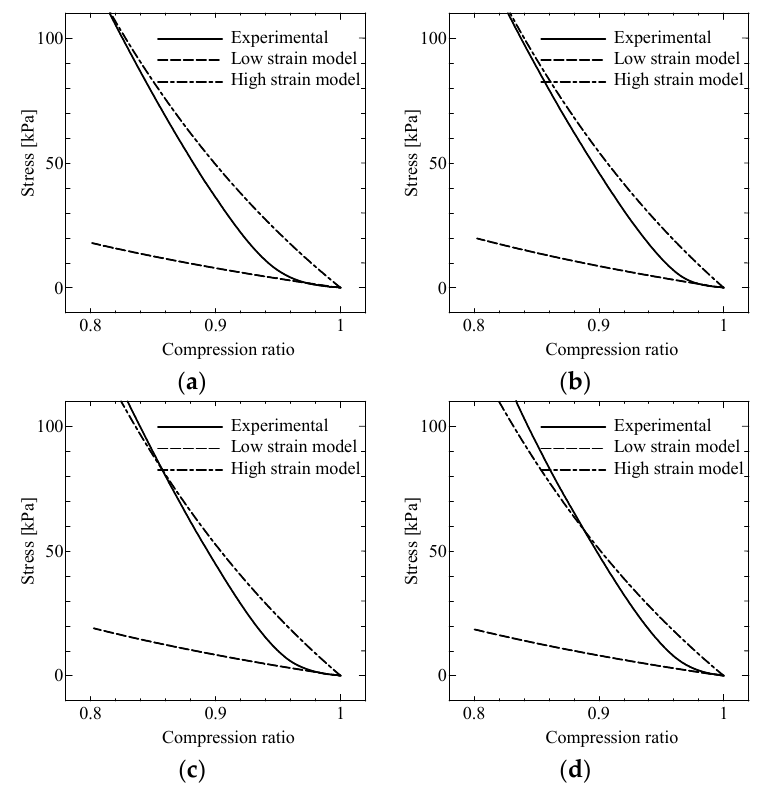
Figure 5. Model of the stress curve for non-uniform MF, for different PMs: ( a ) 0 mT; ( b ) 260 mT; ( c ) 320 mT; ( d ) 420 mT.